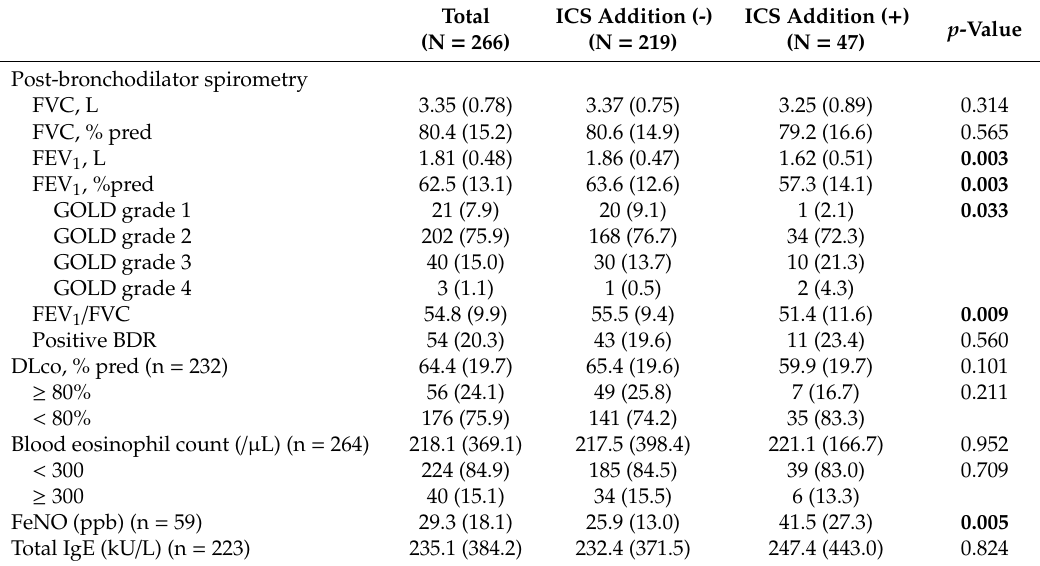
Table 2. Pulmonary function test and laboratory findings of 266 patients according to ICS addition after LAMA / LABA fixed-dose combinations therapy.